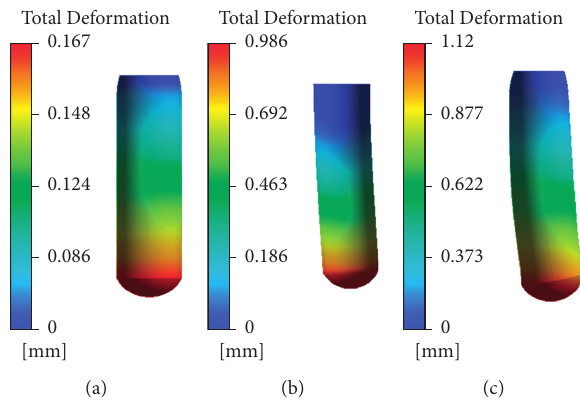
Figure 10: Contours of thermowell deformation. (a) Temperature load. (b) Pressure load. (c) Temperature +pressure load.